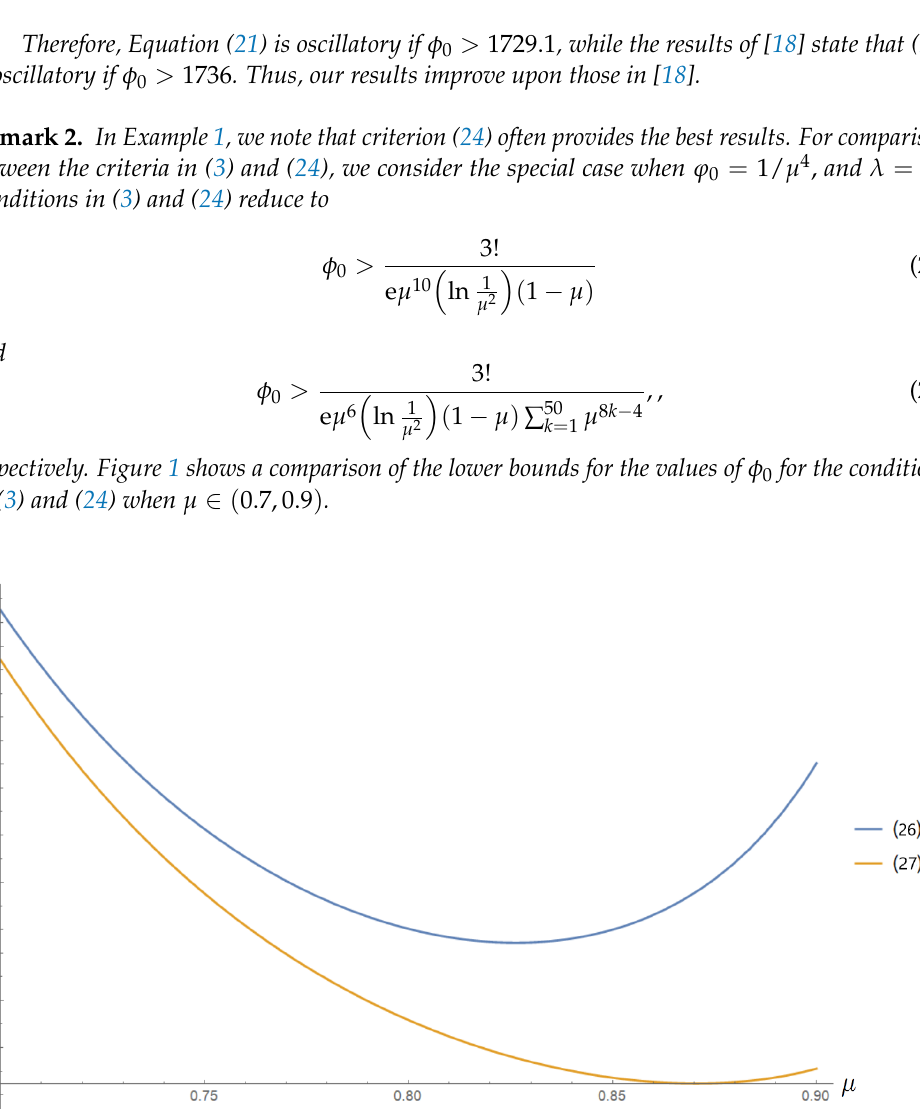
Figure 1. The minimum values of φ 0 for which (3) and (24) are